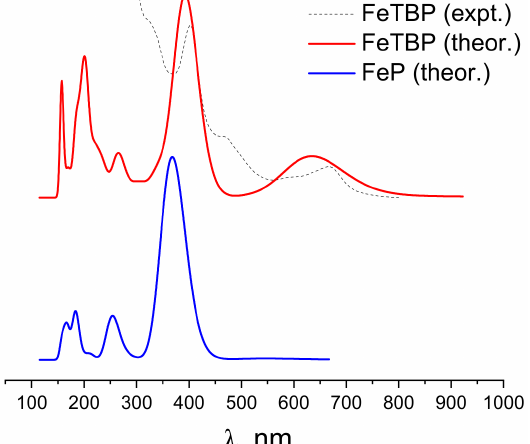
Figure 4. Normalized theoretical (sTDDFT) and experimental (for FeTBP ) electronic absorption spectra. Gaussian broadening function with FWHM = 0.4 eV was used for the model